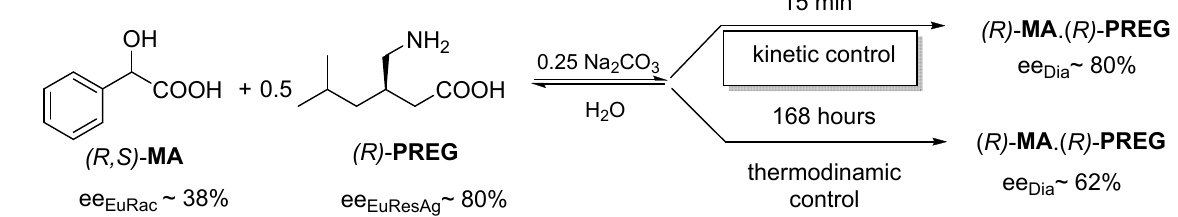
Figure 5. Resolution of racemic MA with ( R )- PREG resolving agent, configurations do not change, however, the more favorable ee Dia is the result of the kinetic control.